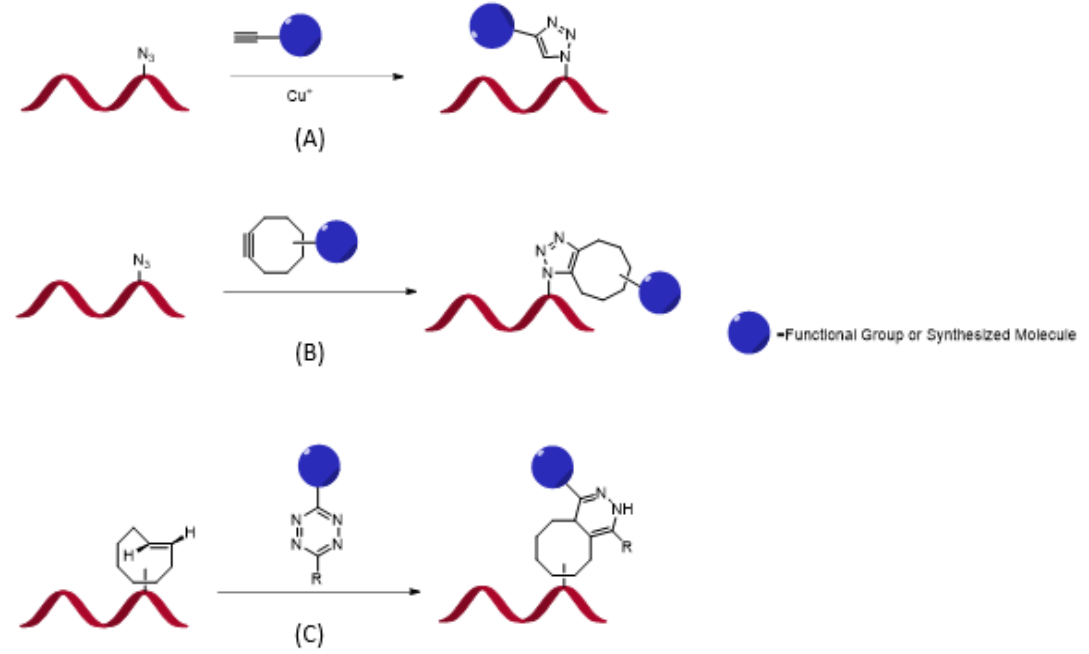
Figure 5. Schematic representation of RNA click reactions; ( A )copper(I)-catalyzed azide–alkyne cycloaddition (CuAAC), ( B ) strain-promoted azide–alkyne cycloaddition (SPAAC), ( C ) inverse electron-demand Diels–Alder cycloaddition (IEDDA).